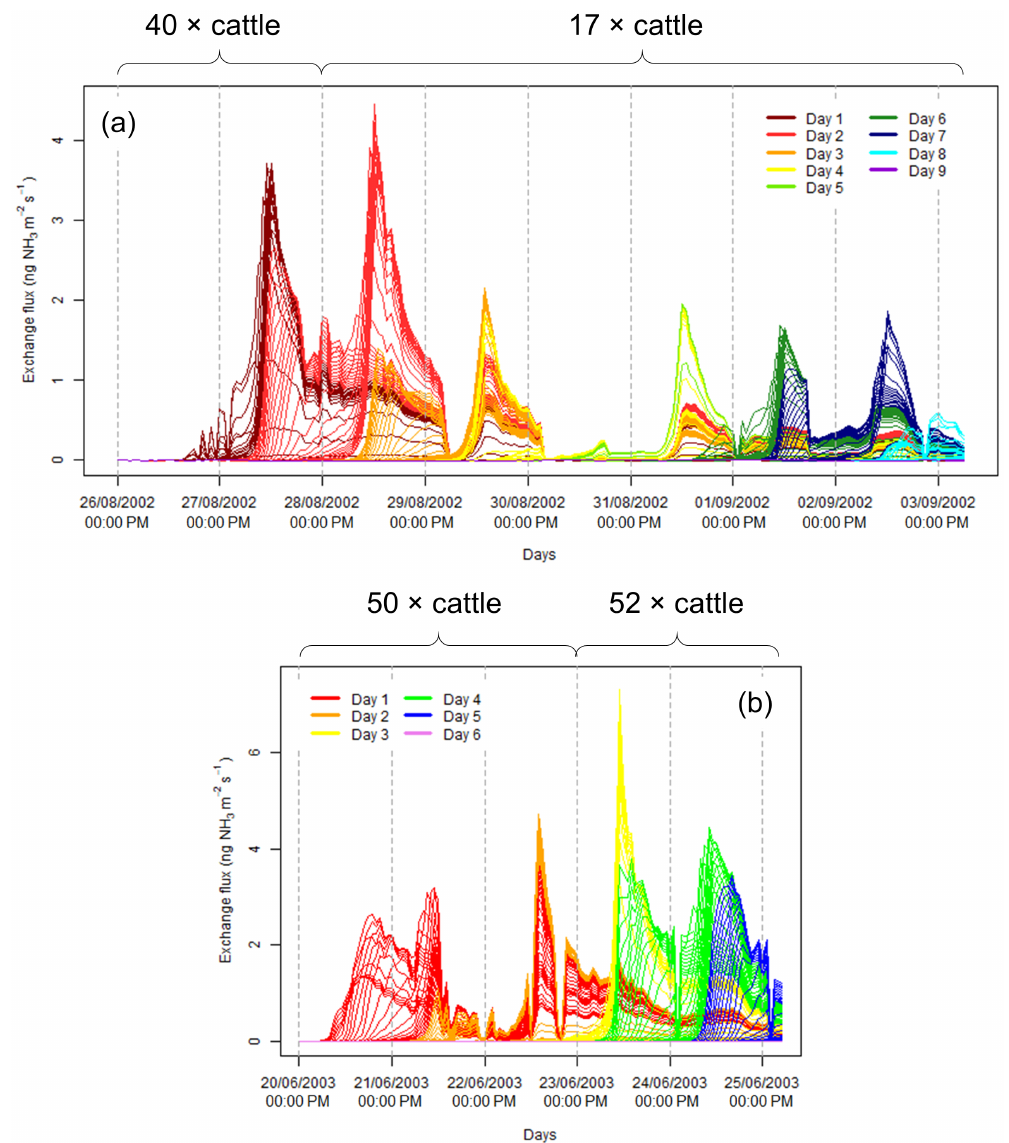
Figure 11. Simulated NH 3 fluxes from urine patches deposited in the same time step in the modelling periods P2002 (a) and P2003 (b) . Each line indicates NH 3 fluxes from urine patches deposited in a given time step (expressed for the whole field), while the different colours indicate the days of the urination events. The number above the plots show how many cattle were grazing in the given time